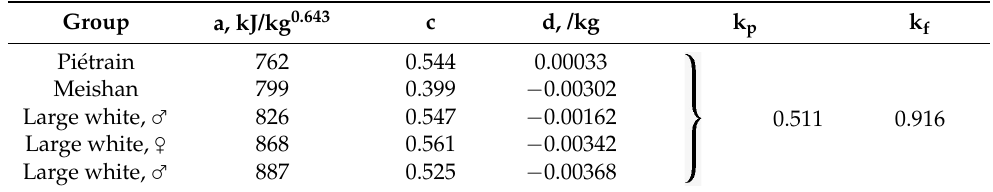
Table 1. Modeling coefficients for describing energy utilization in various genetic lines of pigs. a is the maintenance requirement; c is the fraction of metabolizable energy (ME) supplied in excess of maintenance, which is designated for protein deposition at 20 kg of body weight; d is the change in partitioning of ME toward protein deposition due to a change in body weight; k p is the partial efficiency of protein deposition; and k f is the partial efficiency of lipid deposition [6]. Group a, kJ/kg 0.643 c d, /kg k p k f Piétrain 762 0.544 0.00033 Meishan 799 0.399 − 0.00302 Large white, ♂ 826 0.547 − 0.00162 0.511 0.916 Large white, ♀ 868 0.561 − 0.00342 Large white, ⚦ 887 0.525 − 0.00368